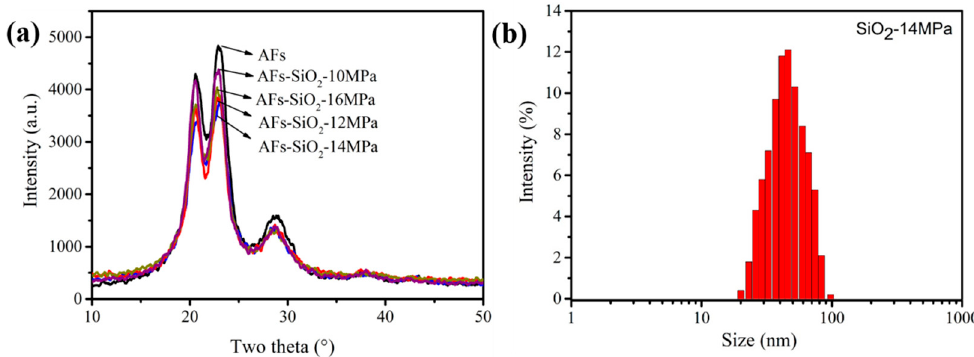
Figure 4. XRD patterns of the untreated and nano-SiO 2 modified fibers ( a ). Particle size distributions of nano-SiO 2 -14MPa ( b ).